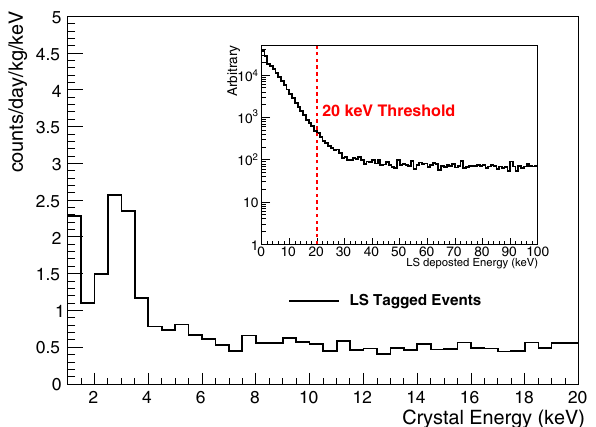
Fig. 6 The spectrum of Crystal-1 signals that occur in coincidence with LS signals with E > 20keV is shown. The 3keV 40 K events are tagged in the LS system with a 72% efficiency